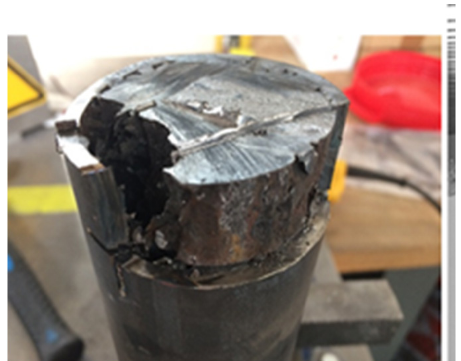
Figure 9. Small representative component coated with protective layer after test in AlSi 12 .